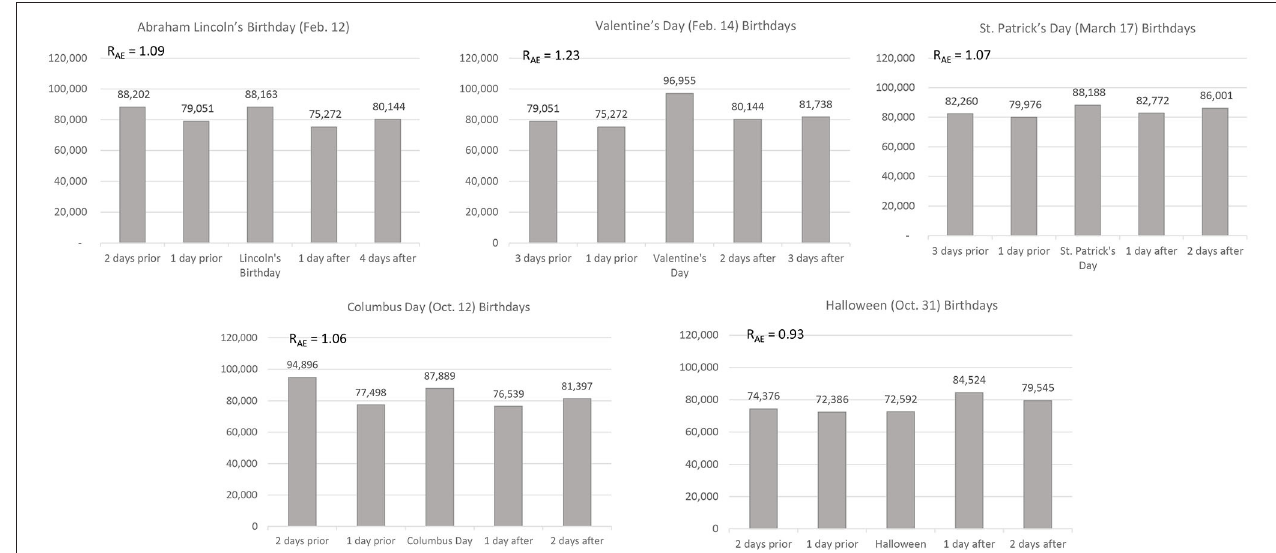
FIGURE 2 | Birthday selection: claiming a minor holiday as a birthday for one’s child in the U.S. (1890–1910). When a control day would have been (A) a holiday or (B) the 15th of the month (for which there were not valid data), we chose the next available valid day as a control day. The + 9.0% bias for Lincoln’s birthday was reduced to + 6.9% when ignoring the 13th (a disliked day). The same adjustment for Valentine’s Day yielded a + 20.7% bias. The − 7.0% bias for Halloween became − 3.8% when ignoring the first of the month (see Study 4). Finally, the positive biases for both Lincoln’s birthday and Columbus Day grow larger when ignoring the highly liked and frequently chosen 10th of the month as a control